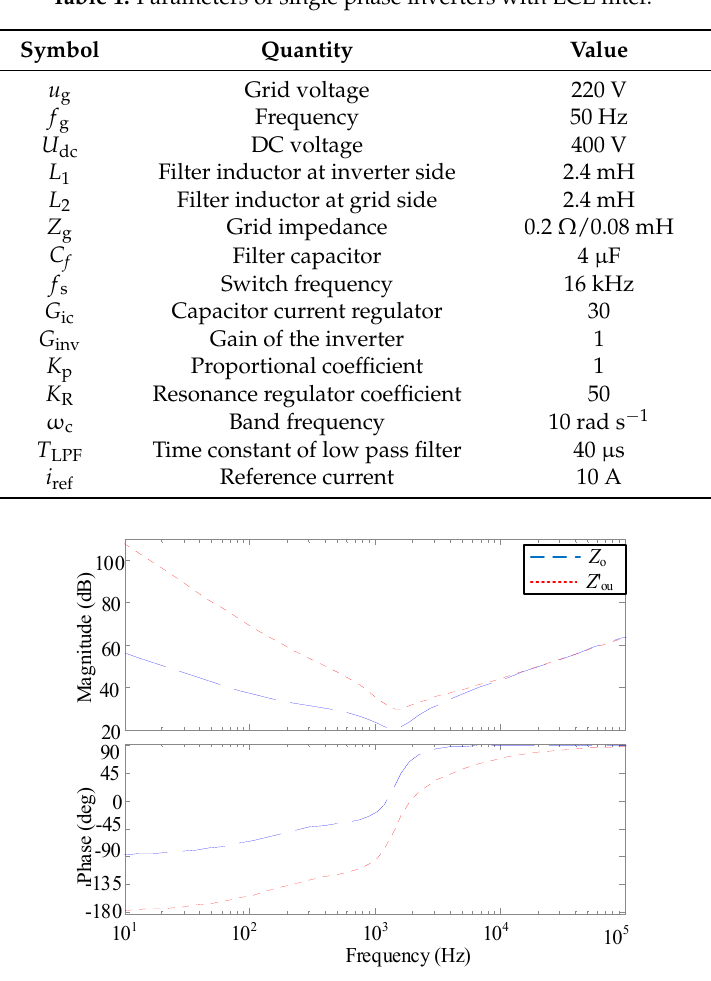
Table 1. Parameters of single phase inverters with LCL filter.